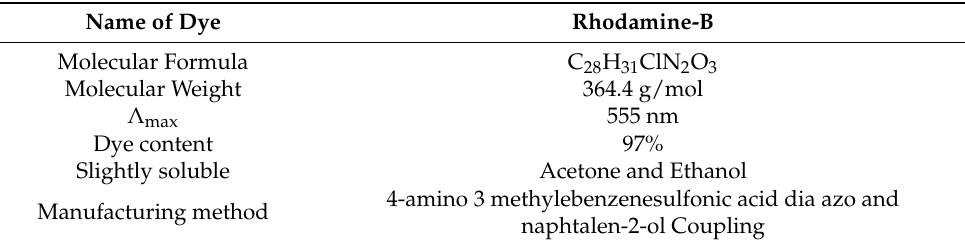
Figure 1. Chemical structure of rhodamine-B. Table 1. Physiochemical properties of rhodamine-B